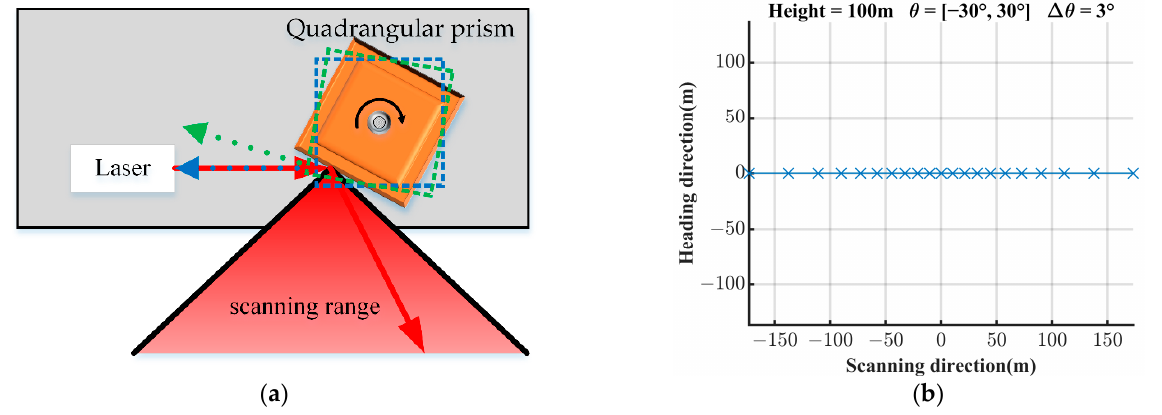
Figure 4. Quadrangular prism scanning mode 1. ( a ) Scanning schematic diagram; ( b ) Scanning track